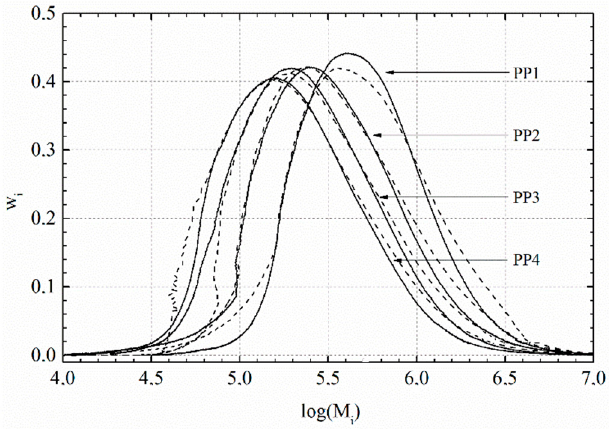
Figure 6. MMD of the linear PP samples (compact lines) and the LCB samples (dashed lines).